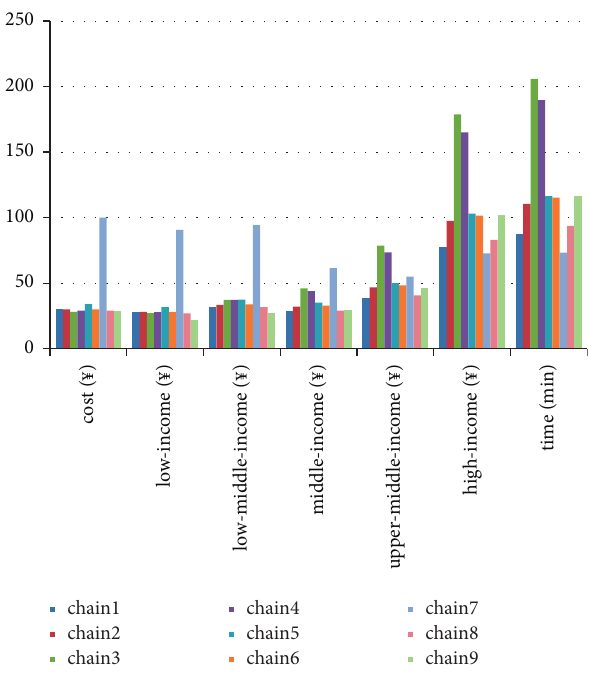
Figure 2: Comparison of different trip chains of seven groups of